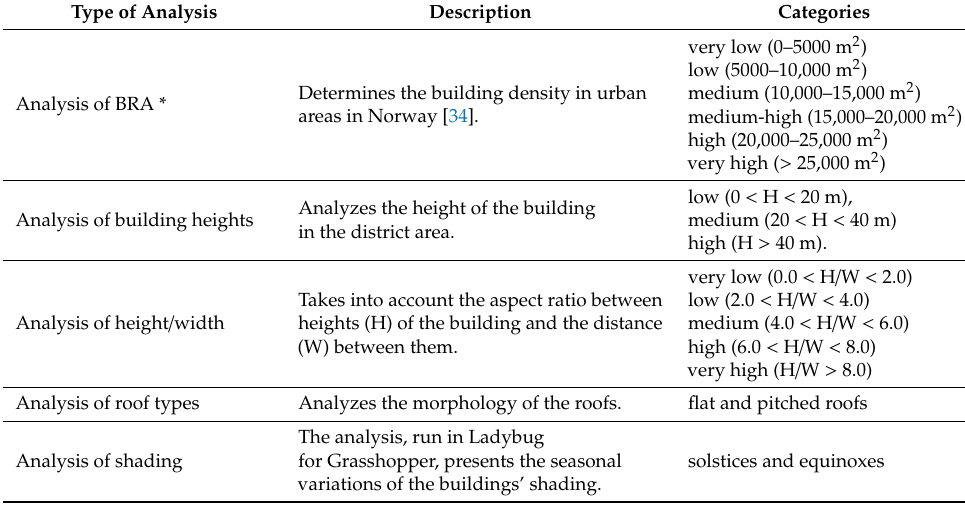
Table 2. Types of analyses conducted in Step 1—Urban